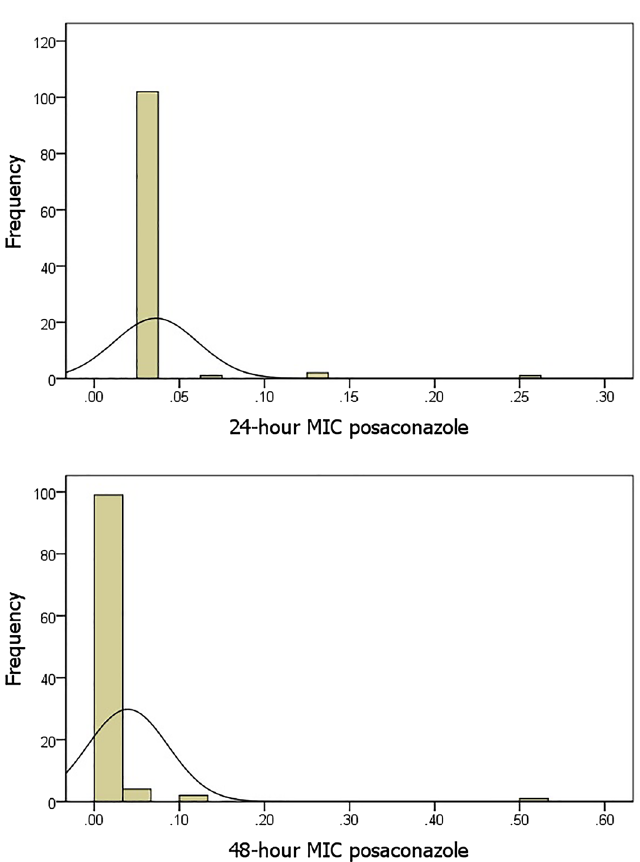
Figure 1. 24-h and 48-h MIC distribution with a histogram of the isolated C. albicans